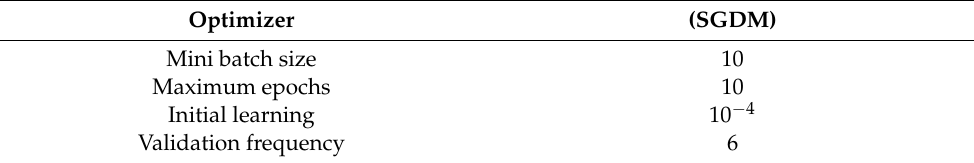
Table 2. Net training settings.